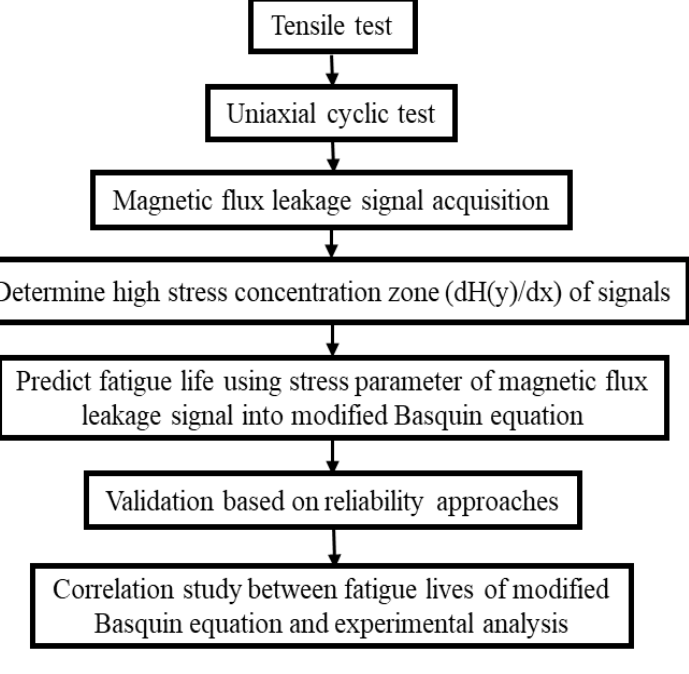
Figure 1. Methodology flow for modified fatigue life model of the Basquin equation process.